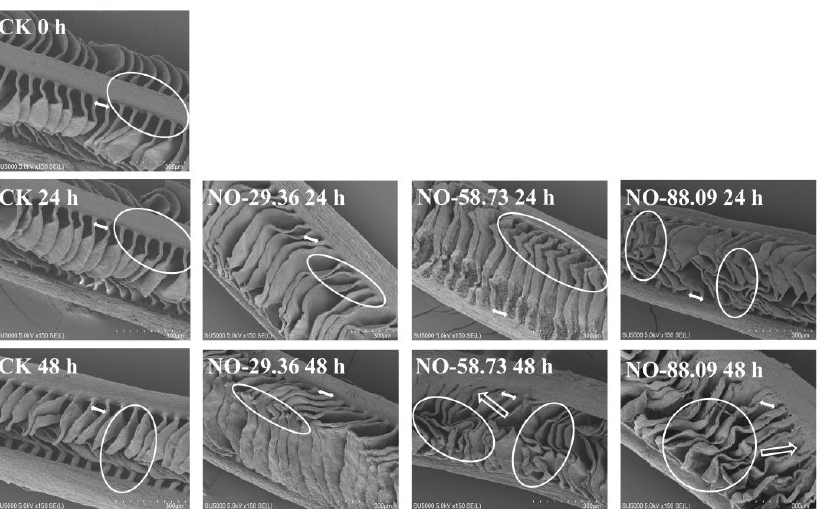
Figure 6. Scanning electron microscope (SEM) micrographs of large yellow croaker gills exposed to nitrite at 29.36 mg/L (NO-29.36), 58.73 mg/L (NO-58.73), 88.09 mg/L (NO-88.09), and 0 mg/L (CK) for 0, 24, and 48 h. Bars = 300 μm. Whitehead arrows designated long lamellae separated by interlamellar spaces.